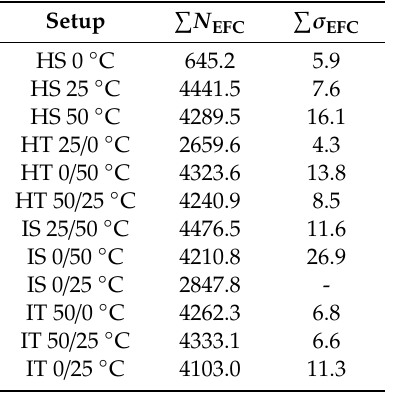
Table A1. Equivalent full cycles and corresponding deviation of each